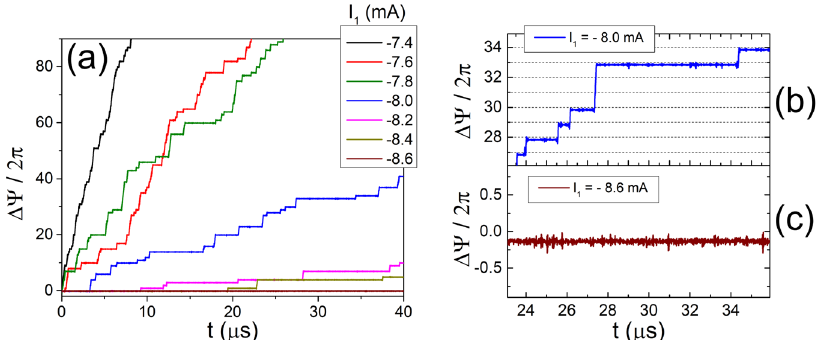
Fig. 4 Phase evolution of two dipolar-coupled oscillators. a The instantaneous phase difference ( Δ Ψ ) is presented as a function of time, for different values of the direct current I 1 passing through oscillator 1 (STVO 1 ). The direct current passing through oscillator 2 (STVO 2 ) is − 5.0 mA. Δ Ψ is zoomed in for ( b ) I 1 = − 8.0 mA and ( c ) I 1 = − 8.6 mA. A perpendicular magnetic fi eld of 2.8 kOe was applied during the measurements.